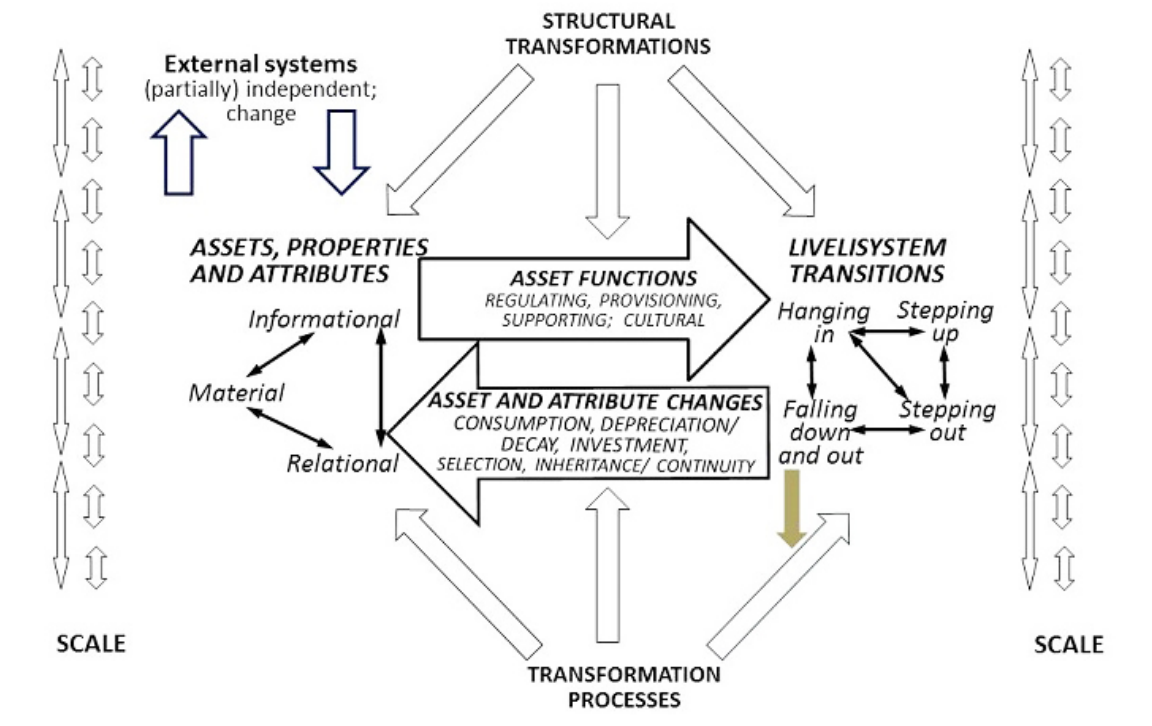
Fig. 1. Livelisystems: broad processes and